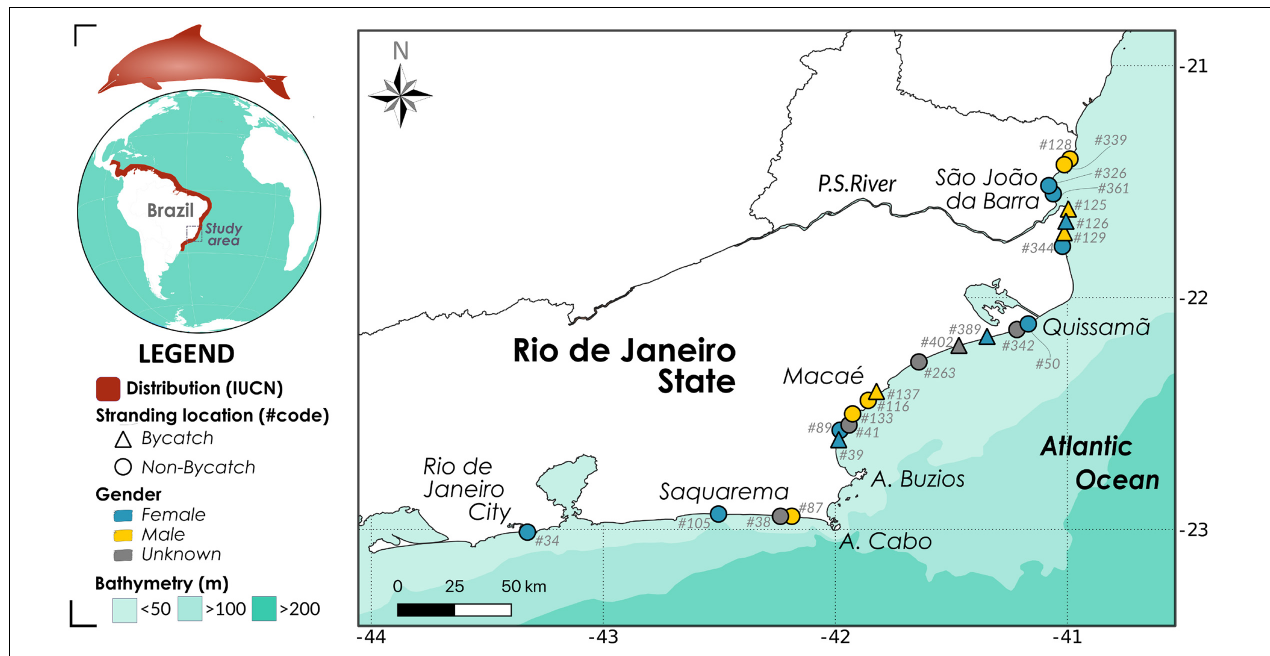
FIGURE 1 | Sampling locations of Guiana dolphin ( Sotalia guianensis ) specimens found stranded or caught as bycatch in the state of Rio de Janeiro, southeastern Brazil. P. S. River-Paraíba do Sul